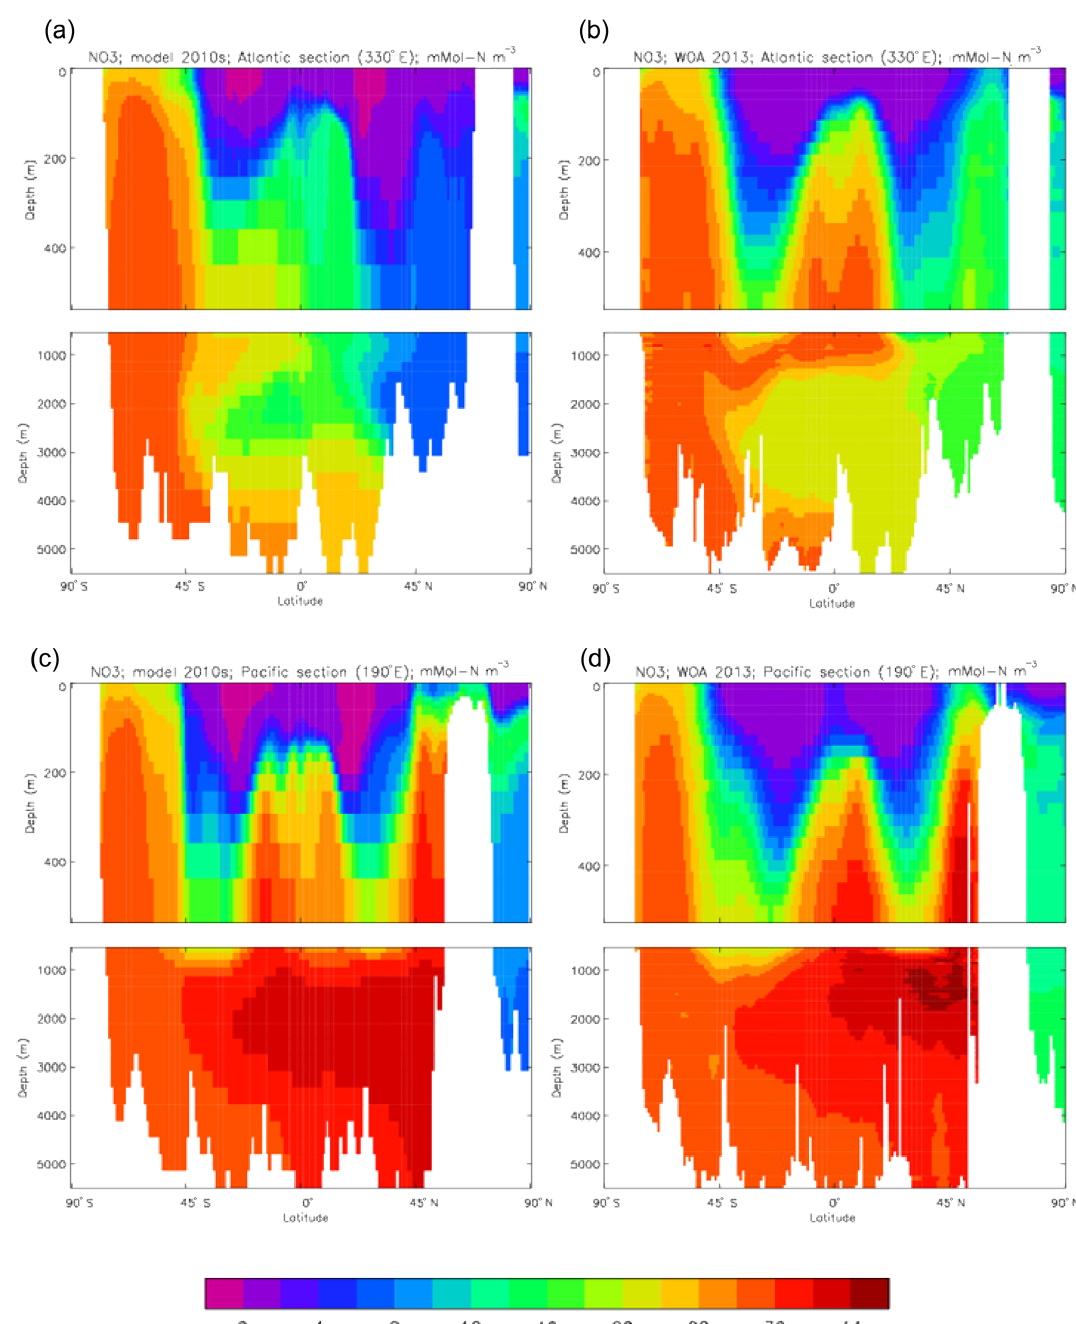
Figure 23. Meridional sections of dissolved nitrate (mMolNm − 3 ): panels (a) and (b) show sections in the Atlantic Ocean along 330 ◦ ; (c, d) Pacific Ocean sections along 190 ◦ . Panels (a) and (c) show model concentrations averaged over 2010–2019; panels (b) and (d) show concentrations from the 2013 World Ocean Atlas gridded